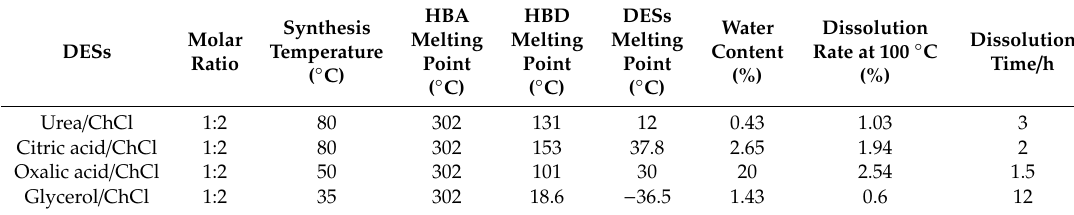
Table 1. The Physical Parameters of deep eutectic solvents (DESs).